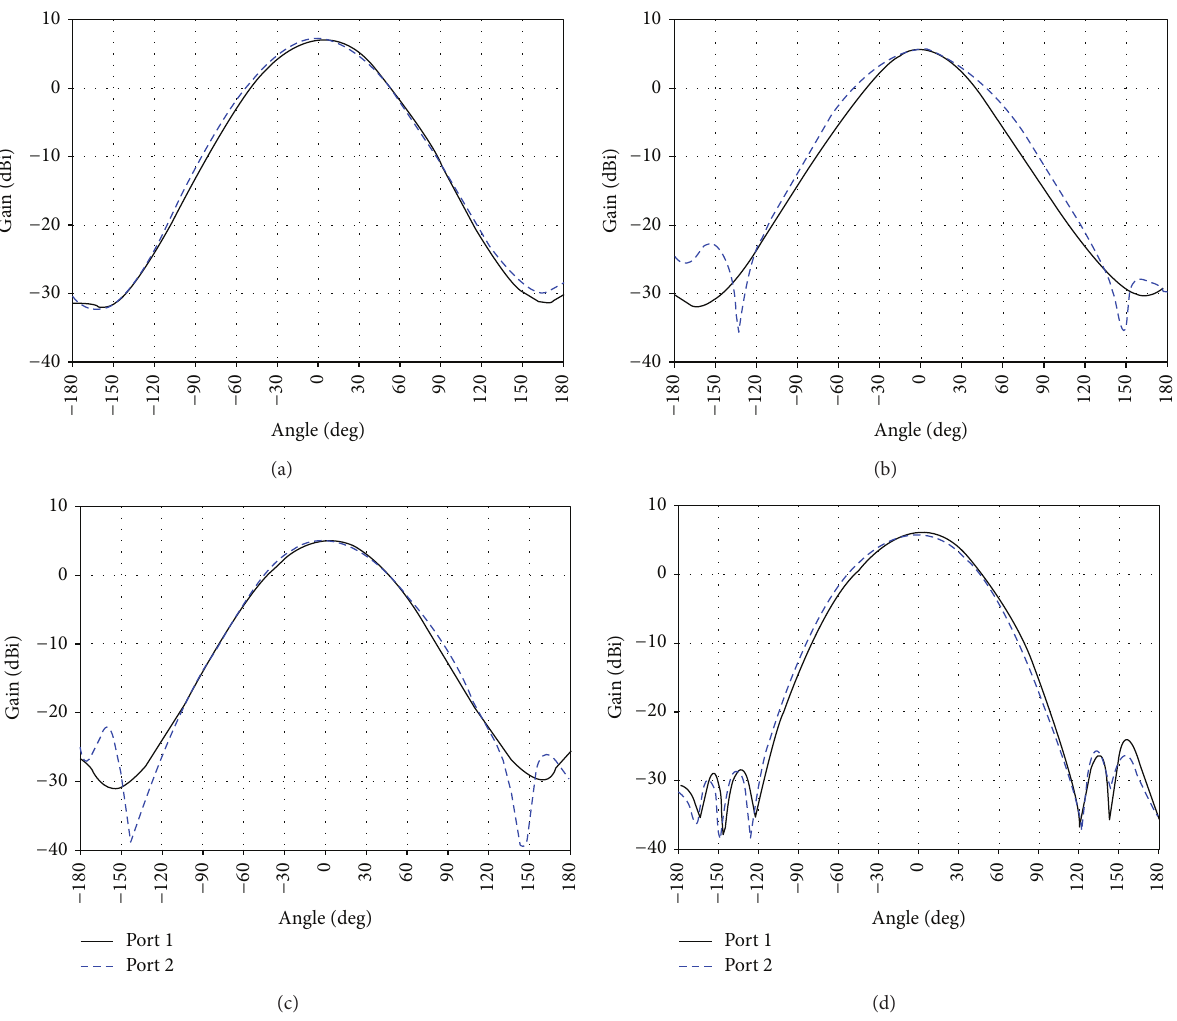
Figure 4: Simulated radiation patterns of the radiators of 𝐸 -plane: (a) 0.881 GHz for Band 1, (b) 2.14 GHz for Band 2, (c) 2.35 GHz for Band 3, and (d) 5.5 GHz for Band